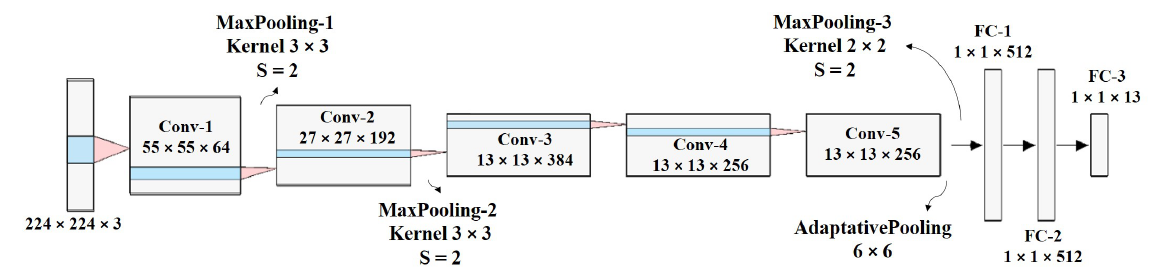
Figure 10. Proposed network for the task of fake banknote recognition, (S:Stride). The figure was generated using NN-SVG